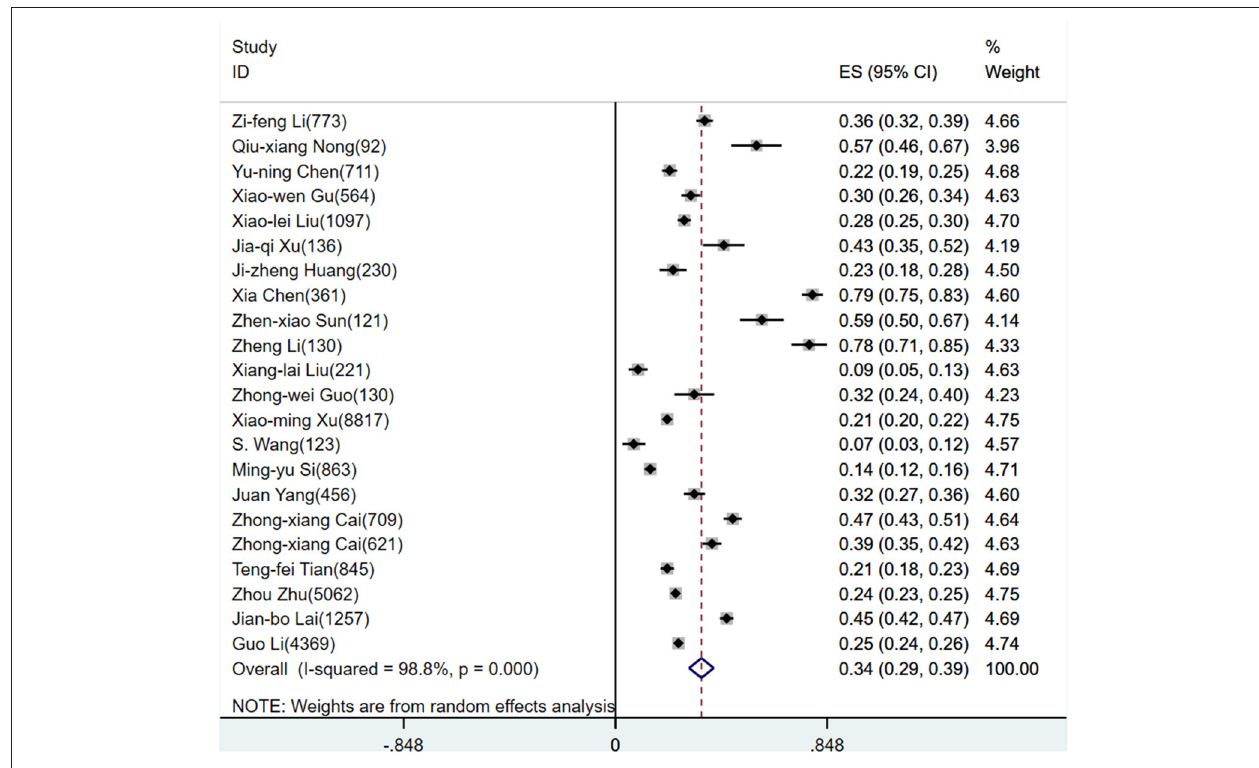
FIGURE 2 | Forest plot of anxiety prevalence rate in Chinese healthcare